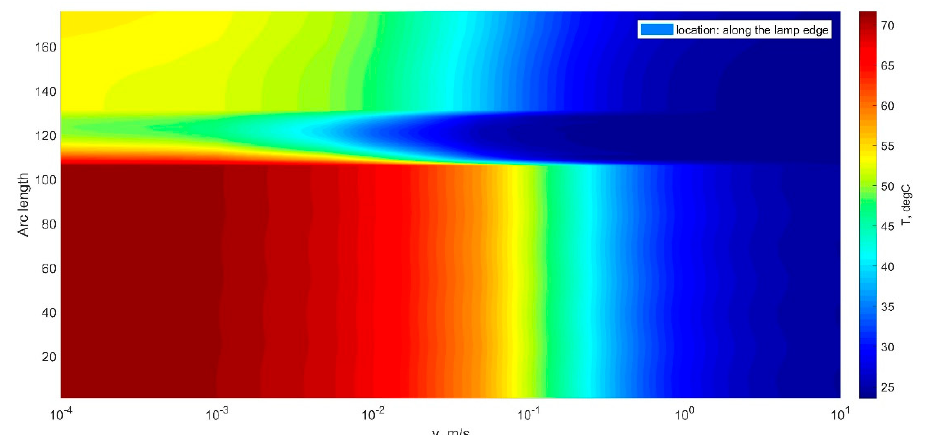
Figure 9. Results of simulations performed using the numerical model depicting the calculated temperature values in dependence from wind speed (log scale) along the lamp edge (see Figure 4b) by ambient temperature T amb = 24 °C.